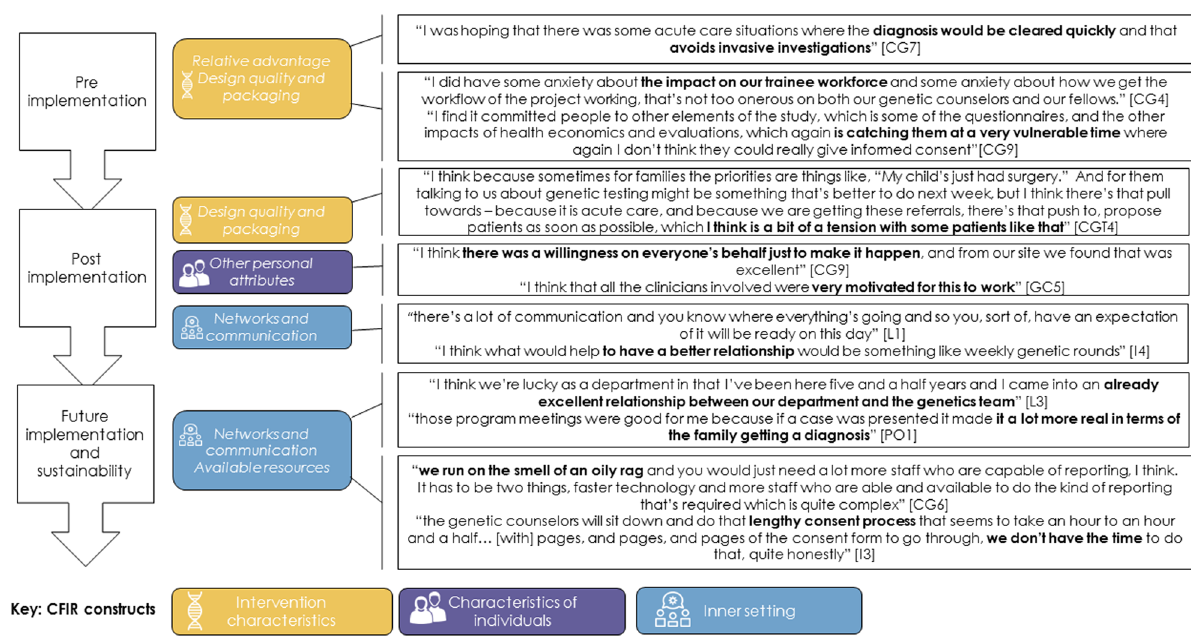
Fig. 4 Differences by implementation phase for fi ndings by Consolidated Framework for Implementation Research (CFIR) domains and constructs, with exemplar quotes. Three CFIR domains (with their associated constructs) are reported: intervention characteristics (relative advantage, design quality and packaging), inner setting (available resources, networks and communications) and characteristics of individuals (other personal